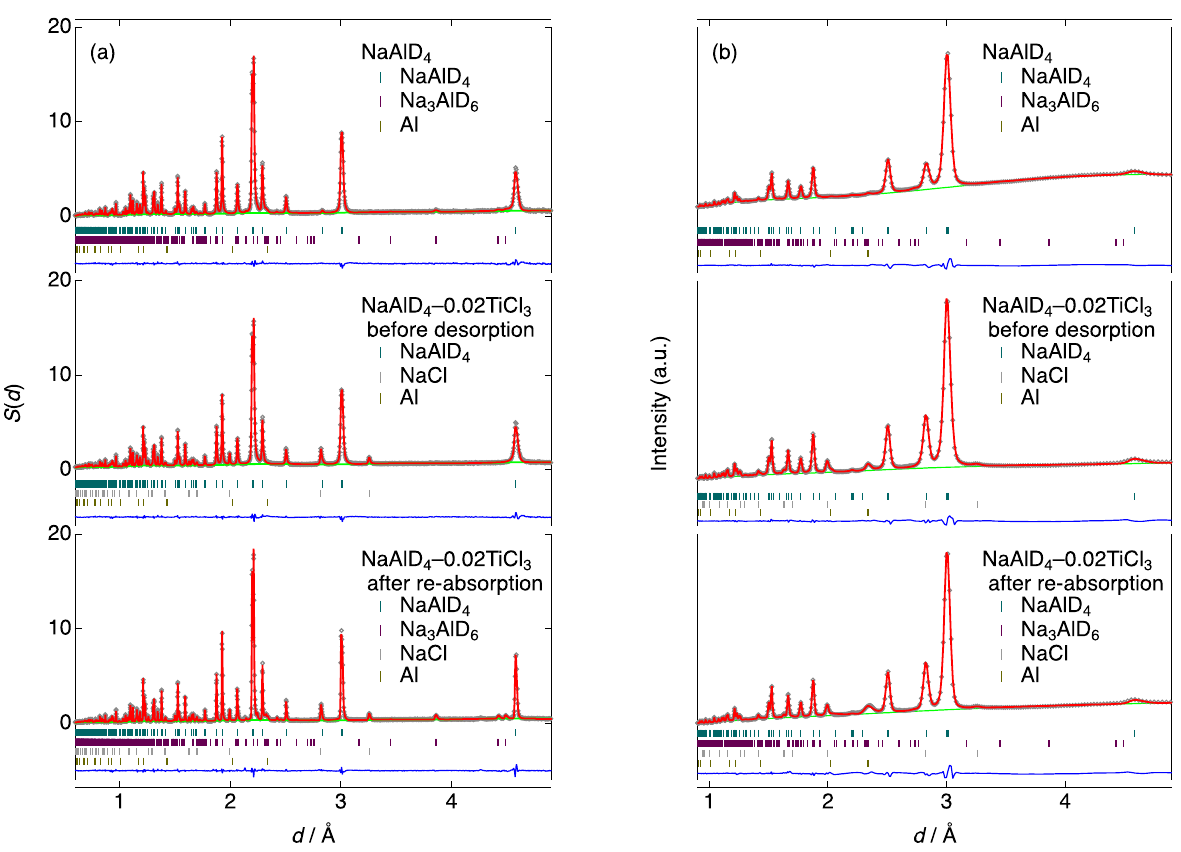
Figure 2. Powder diffraction profiles of NaAlD 4 and NaAlD 4 –0.02TiCl 3 before the desorption and after the re-absorption of deuterium by ( a ) neutron and ( b ) synchrotron X-ray. Rietveld refinement results: observed (circles), calculated (line), and residual (line below the vertical bars) diffraction profiles. The Bragg reflection positions are shown for NaAlD 4 , Na 3 AlD 6 , NaCl, and Al. Table 1. Summary of Rietveld refinement of NaAlD 4 and NaAlD 4 – 0.02TiCl 3 before the desorption and after the re-absorp- tion of deuterium.